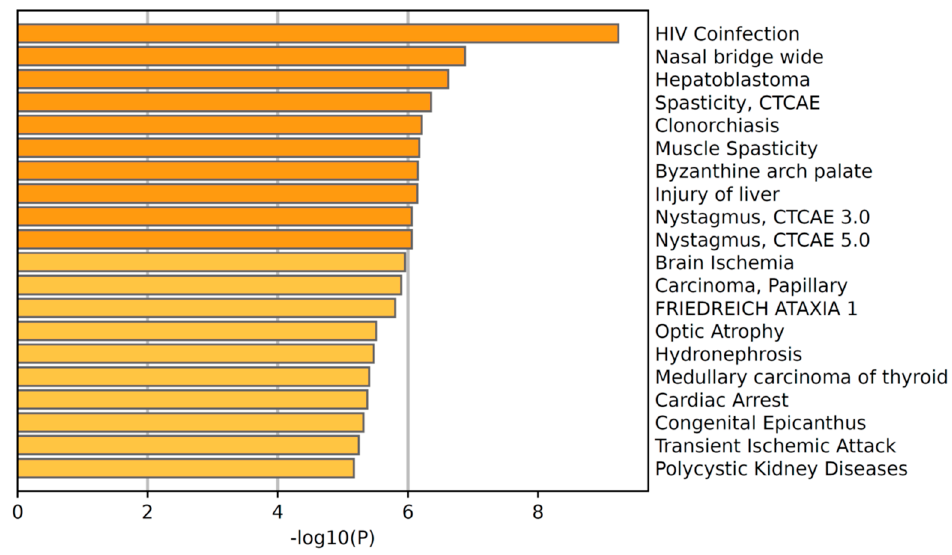
Figure 3. Associated disease enrichment of TbrMam proteins by Metascape tools. This figure only shows the top 20 terms.